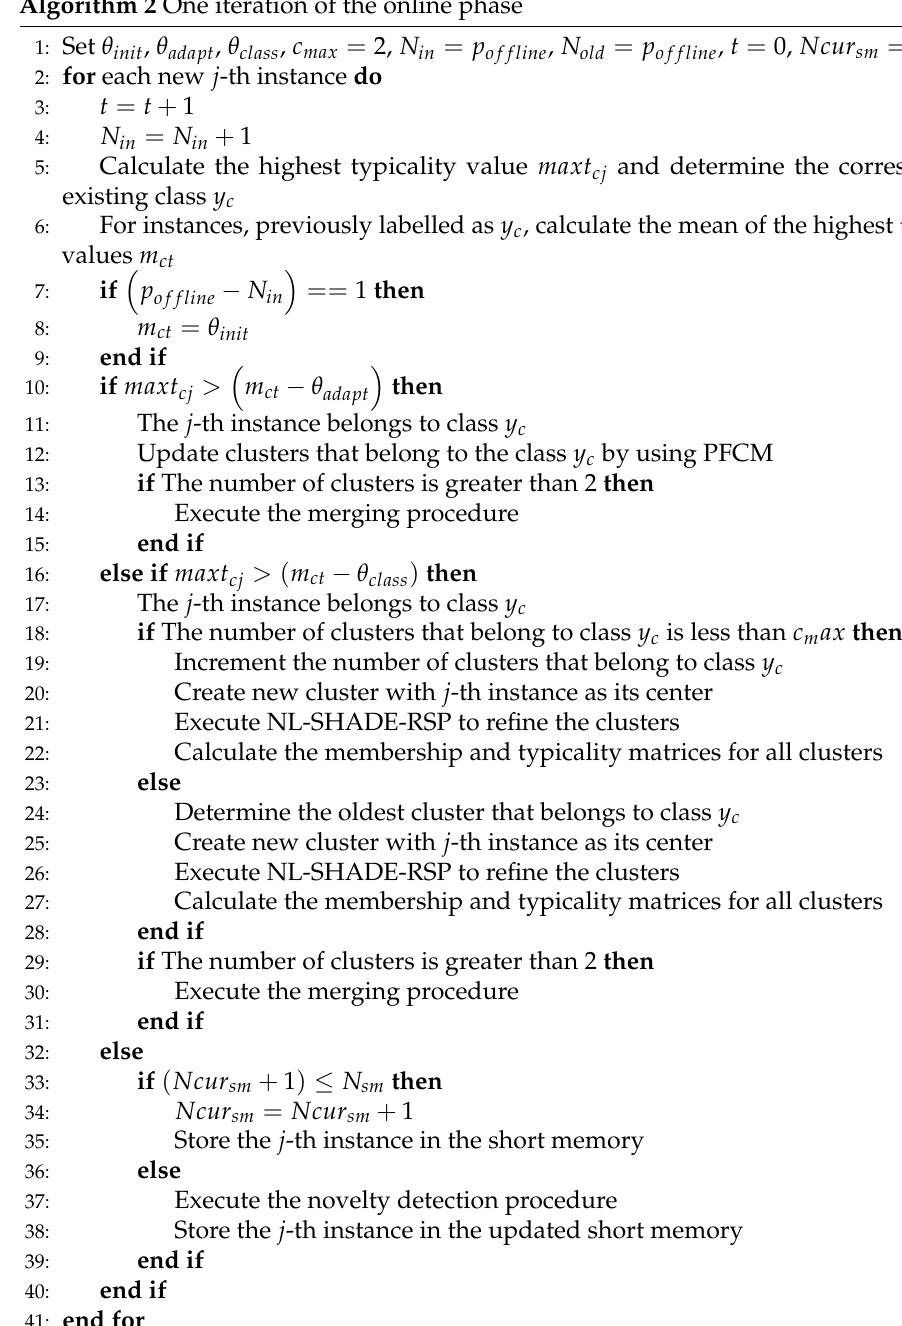
Algorithm 2 One iteration of the online